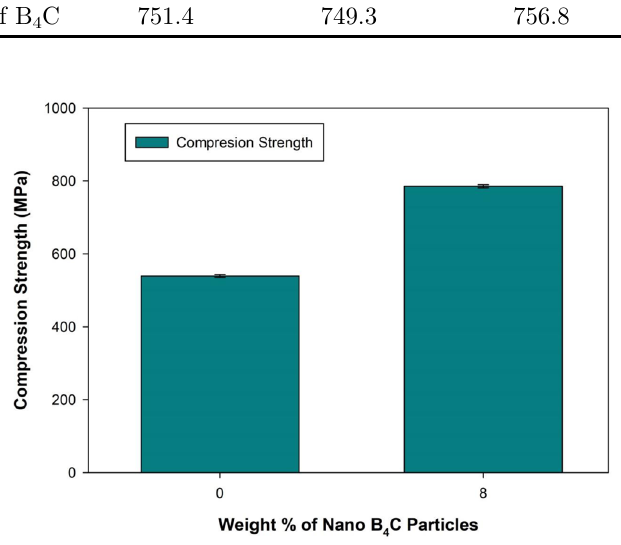
Fig. 12. Compression strength of Al2214 alloy and its